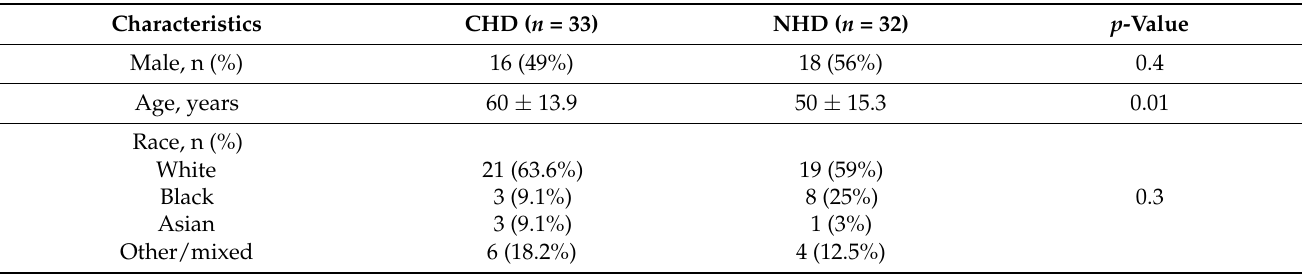
Table 1. Patient characteristics at